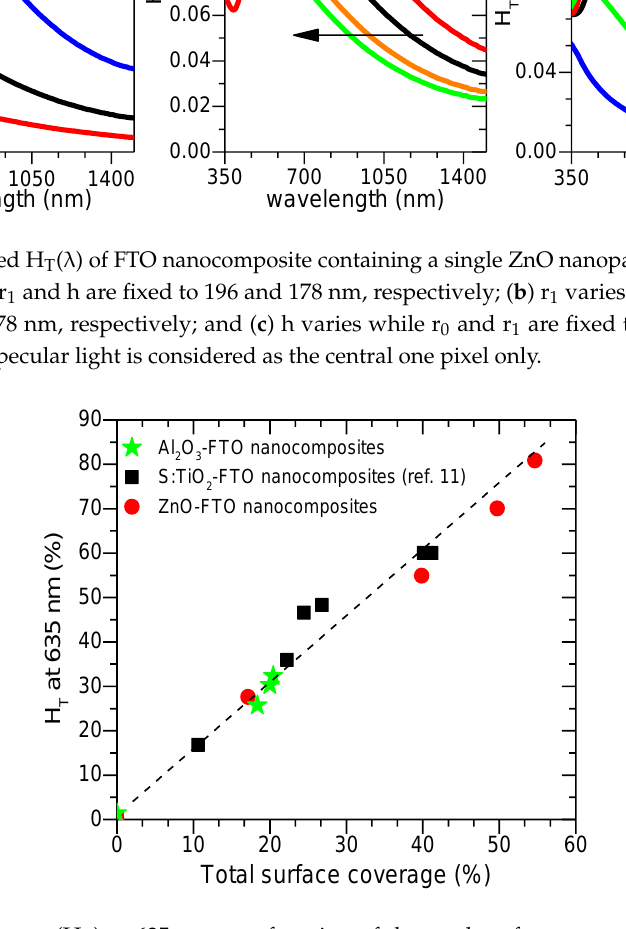
Figure 11. Haze factor (H T ) at 635 nm as a function of the total surface coverage for Al 2 O 3 -FTO, S:TiO 2 -FTO (reported in [11]), and ZnO-FTO nanocomposites.